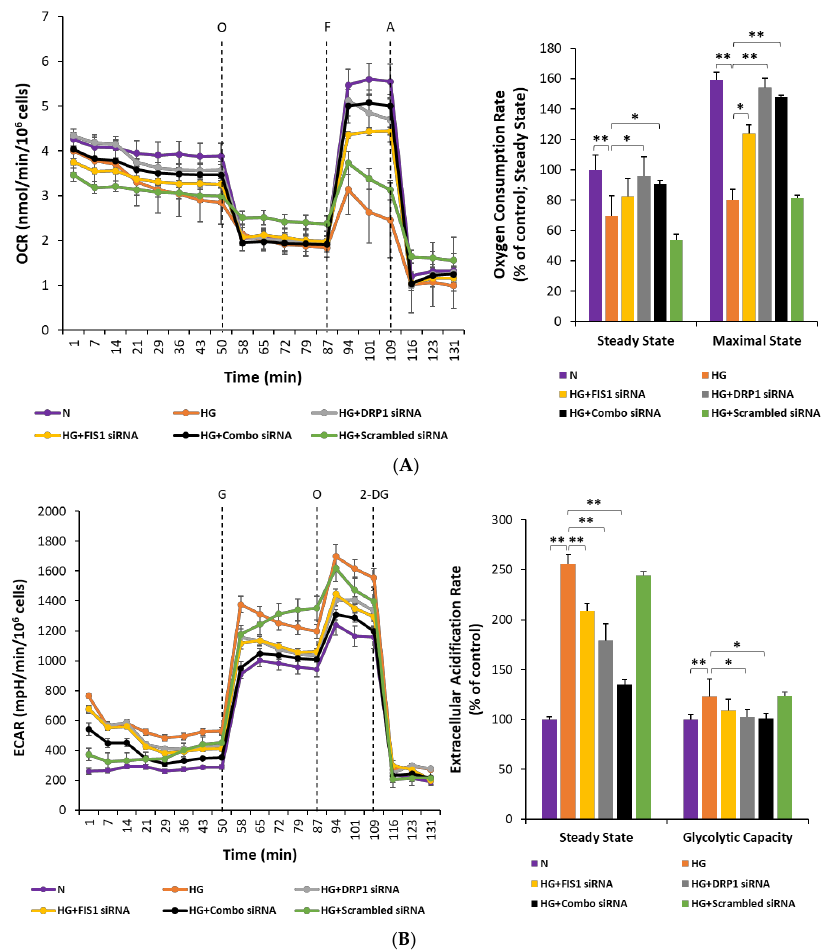
Figure 5. ( A ) Reducing mitochondrial fission protects against HG-induced decrease in